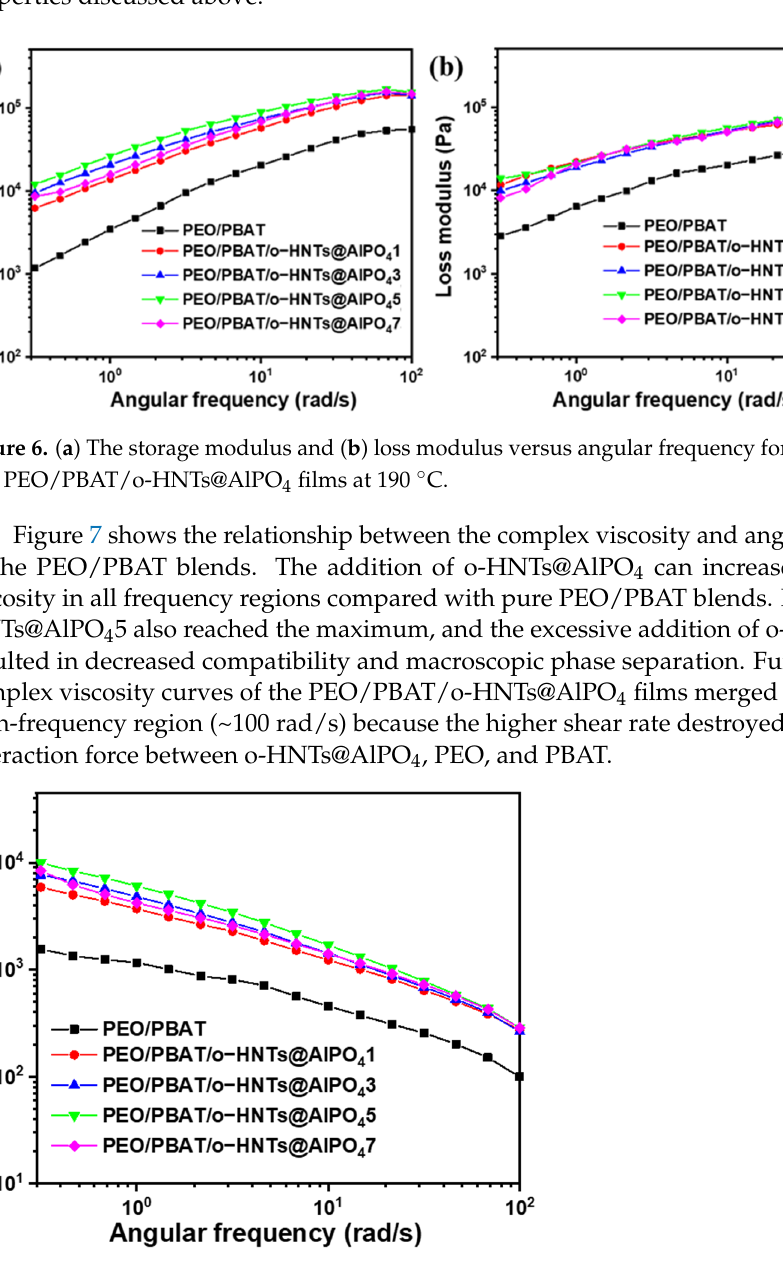
Figure 7. Plots of the complex viscosity versus angular frequency for the PEO/PBAT and PEO/PBAT/o-HNTs@AlPO 4 films at 190 °C.